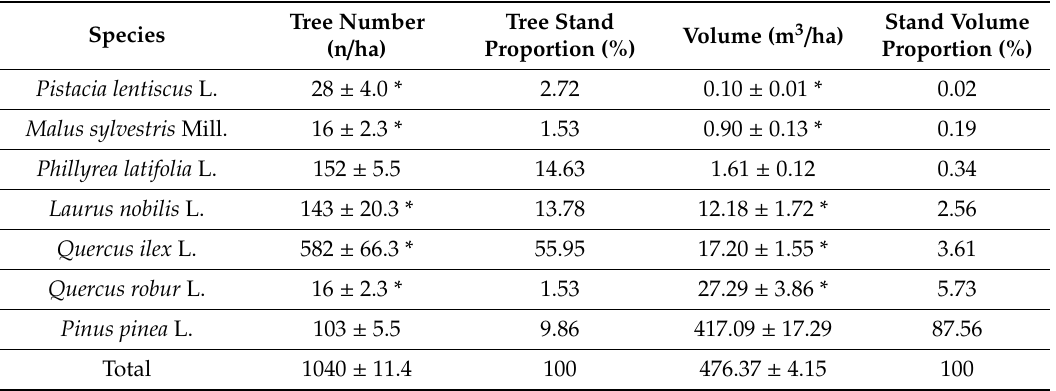
Table 3. Species’ composition and growing stock of living trees (mean ± standard deviation) in the deciduous oak forest. Tree Number Tree Stand Stand Volume Species Volume (m 3 / ha) (n / ha) Proportion (%) Proportion (%) Quercus ilex L.